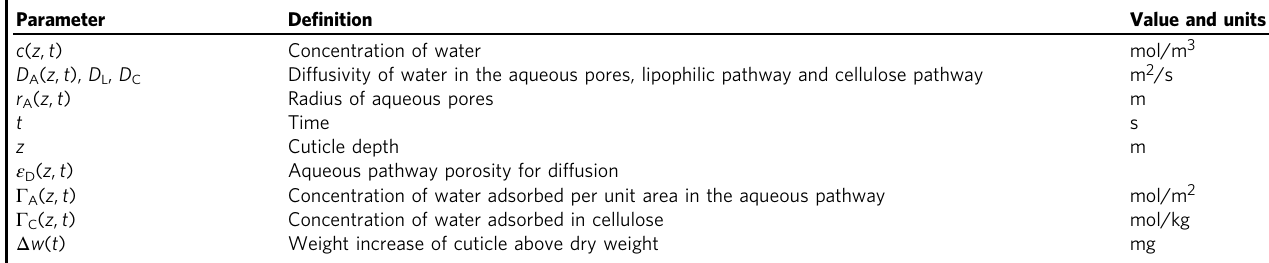
Table 1 Model parameters.